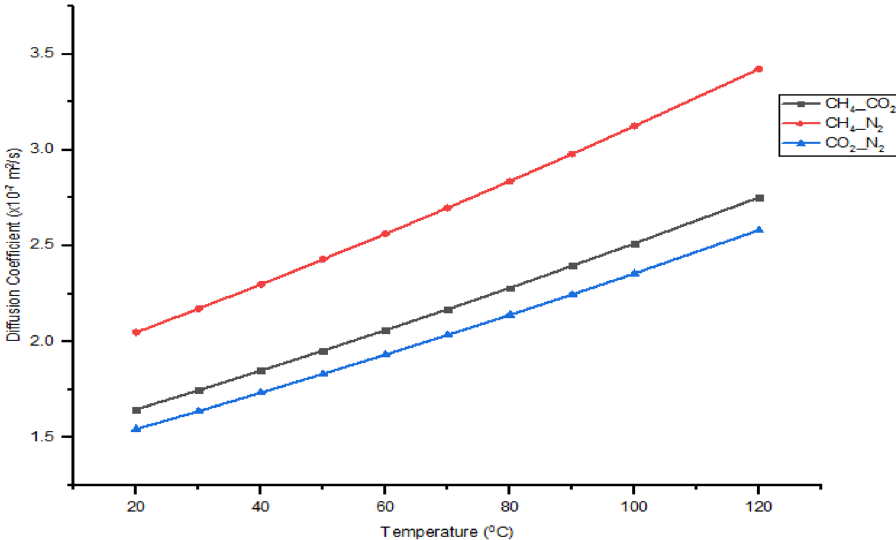
Fig.8 Effect of temperature on diffusion coefficients for CH 4 –